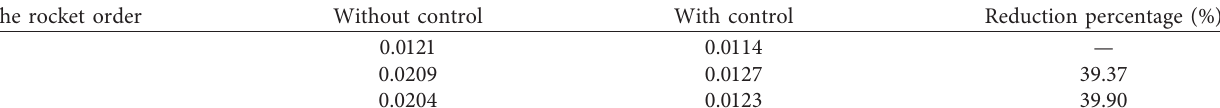
yz in the control period.